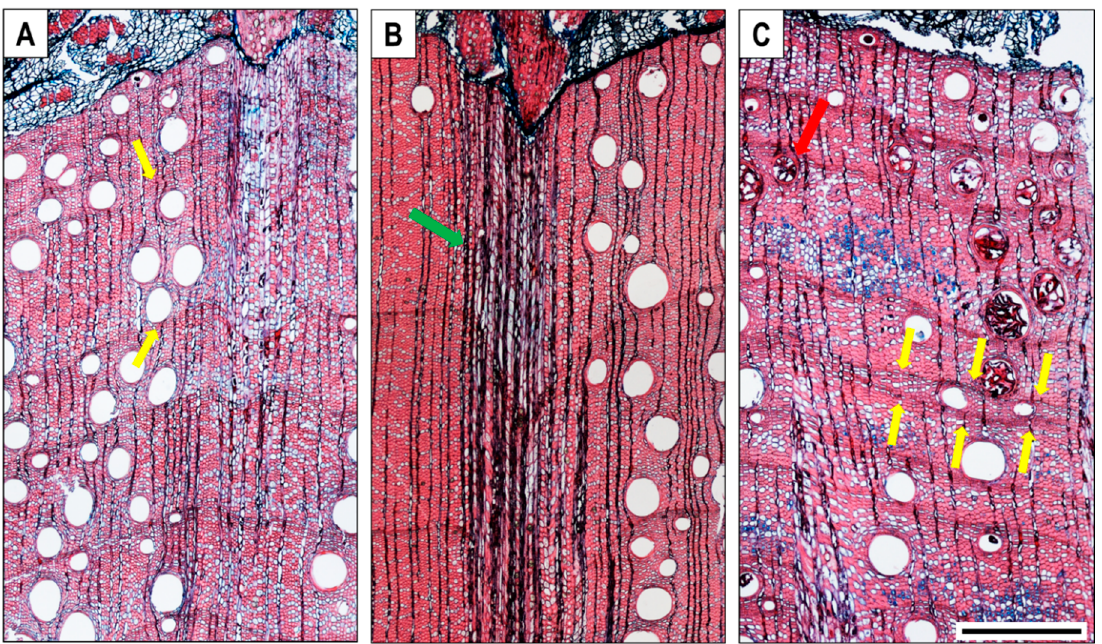
Figure 3. Cross-section of microcores from three different Q. ilex trees showing ( A ) tree-ring structure without clear late- wood (yellow arrows), ( B ) multiseriate ray (green arrow), and ( C ) wedging ring (yellow arrows) and tyloses (red arrows). All images are of the same magnification; scale bar = 500 μ m.